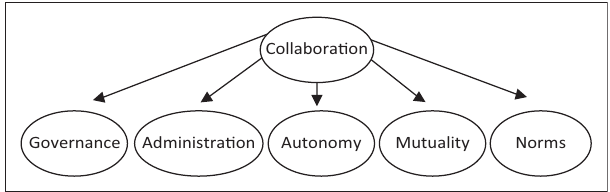
FIGURE 1: Thomson, Perry and Miller (2007) Model of